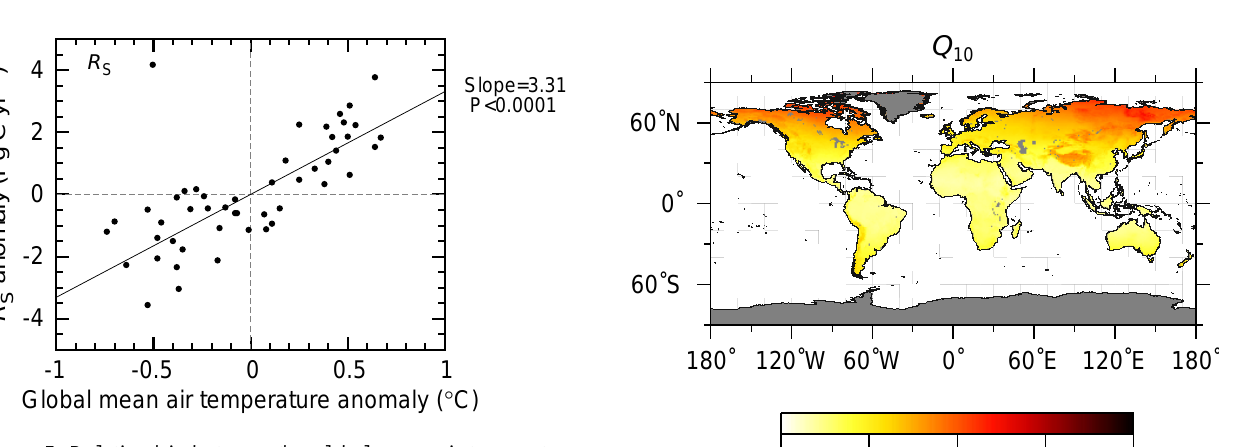
Figure 5. Relationship between the global mean air-temperature anomaly and the soil-respiration anomaly. The anomaly was cal- culated as the deviation from the 1965–2012 mean. Figure 6. Spatial distribution of Q